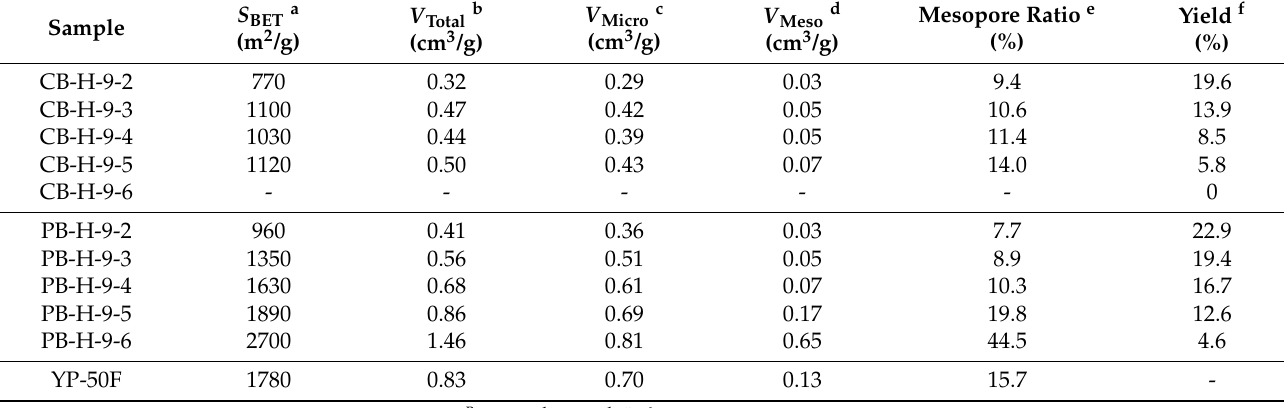
mesopore volume. In contrast, in stage II, PB-AC has a mesoporous structure because the mesopore volume increased more than the micropore volume. Table 1. Textural properties of bamboo-derived activated carbon samples as a function of activation conditions. Sample